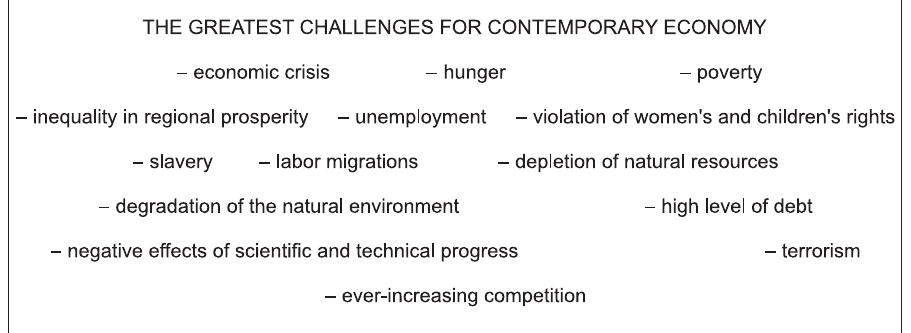
Source: own study based on: Challenges of the 21st Century , http://www.21stcentury challenges.org/challenges/, 25.04.2021.